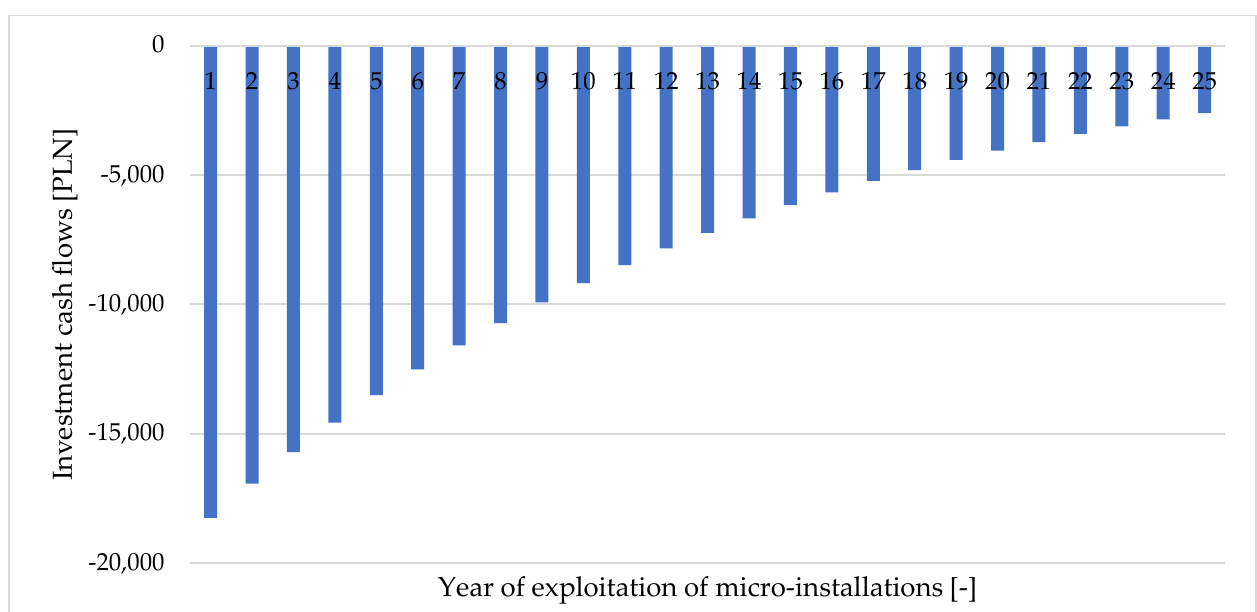
Figure 5. Graph showing the investment cash flow as a function of time of operation for the net-billing system based on monthly prices and a 30% self-consumption level.